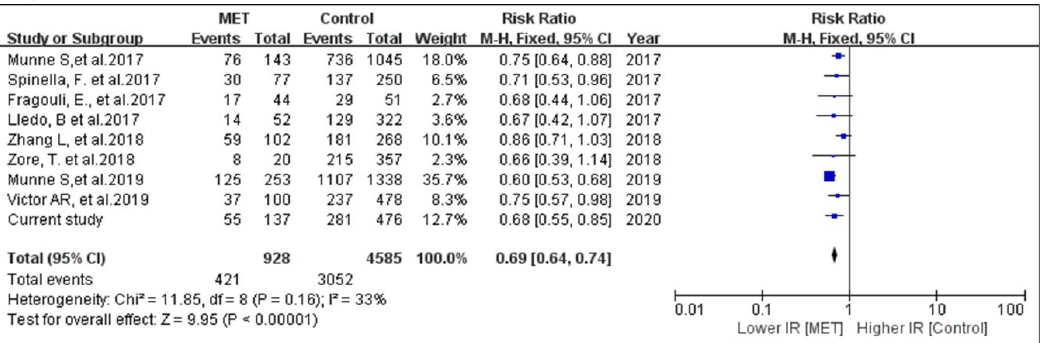
Figure 2. Meta-analysis of the comparison of pregnancy outcome between mosaic and euploid embryo transfers. Data from previous publications [2,3,11–15,29] and the current study. Comparison between MET and euploid ETs for the number of implanted embryos.